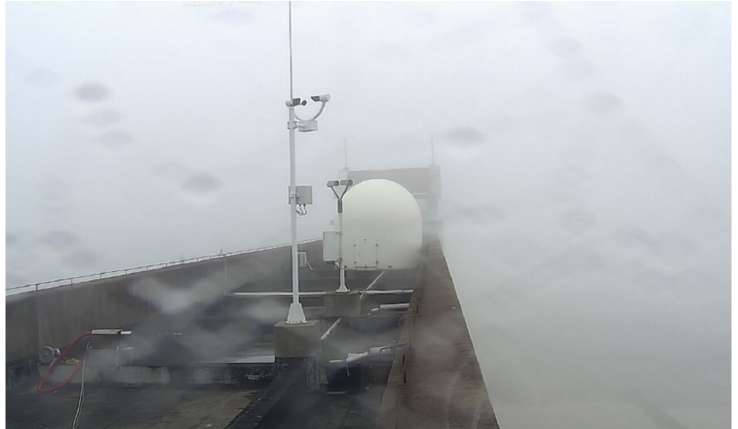
Figure 5. A real-time photograph of sea fog at 6:03 (LT) on 15 June 2021 at the port where the droplet spectrometer is located. The lower left corner of the photograph is the fog monitor (FM-120).